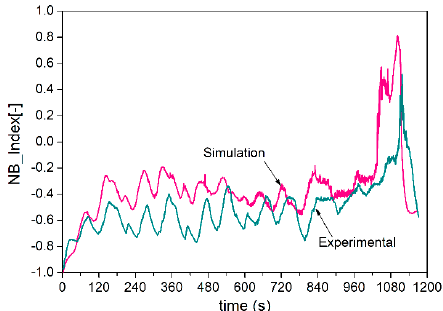
Figure 8. NB_Index during the NEDC; comparison between numerical simulations and experimental tests.